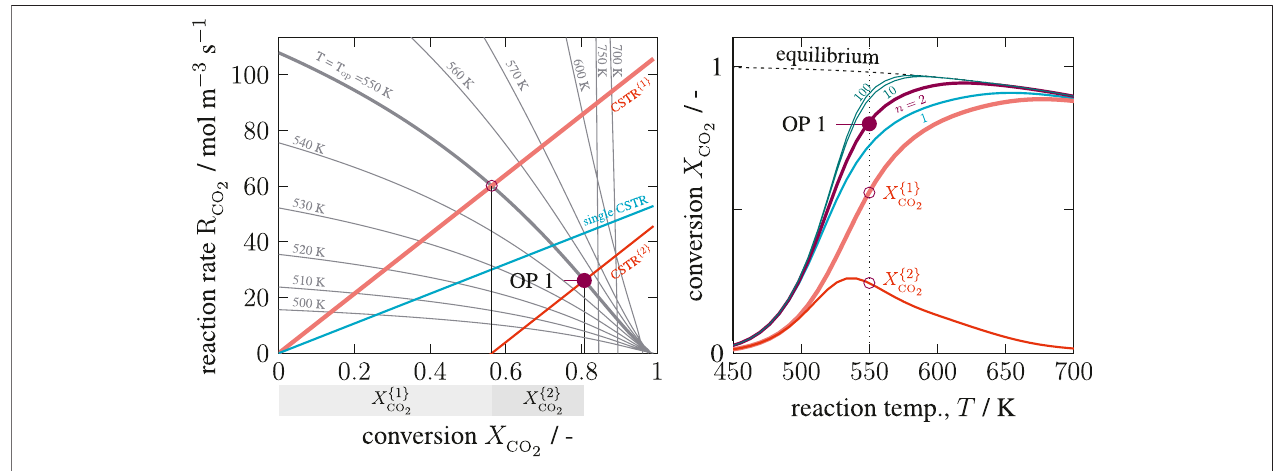
FIGURE 6 | State-space diagram for a cascade of two isothermal Continuous Stirred Tank Reactors (CSTRs) in the R – X (left) and X – T (right) plane, reference setting taken from Supplementary Table S1 but T op (cid:2) 550 K.